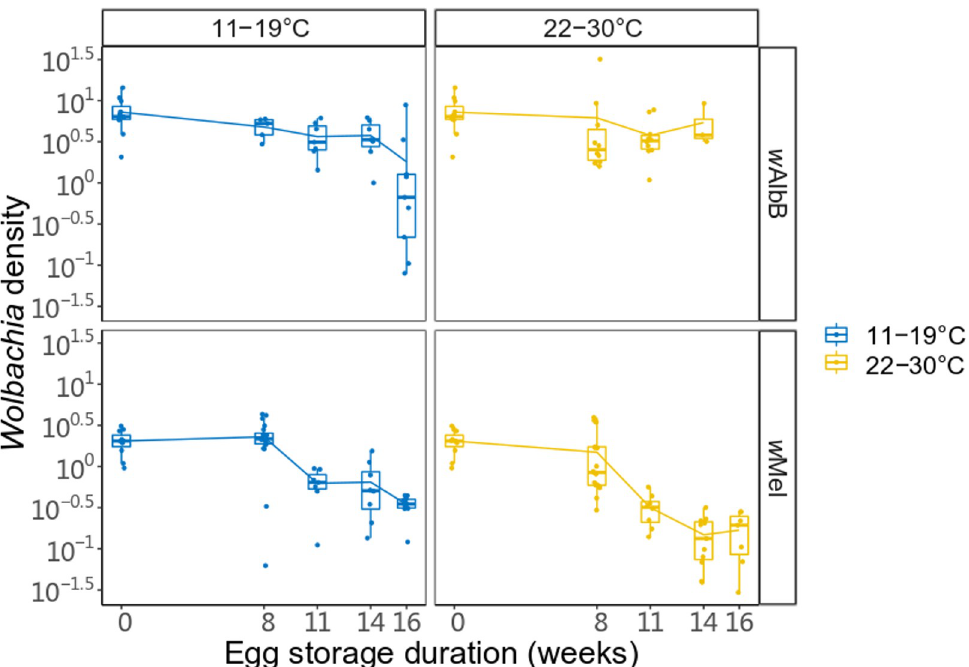
Fig 2. Wolbachia density declines with egg storage. Box plots of l og relative Wolbachia density of w Mel-infected or w AlbB-infected 2-day-old female mosquitoes hatched from eggs stored under temperature cycles of 11–19˚C or 22–30˚C for 0, 8, 11, 14 or 16 weeks. Points represent